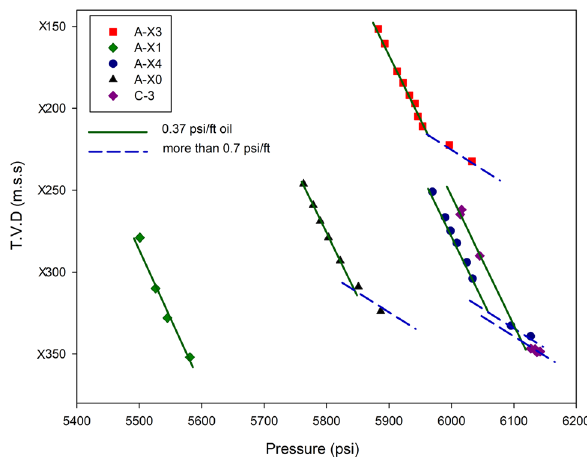
Fig. 8 Cross section of the Main Ilam reservoir between Fields A and B (view to Field C). Well A-X3 has the potential to trap water during oil migration and create a perched